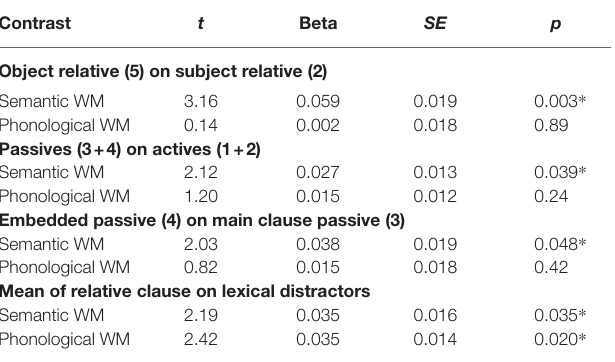
TABLE 8 | Coefficients and significance levels for the independent contributions of semantic and phonological WM to relative clause sentence